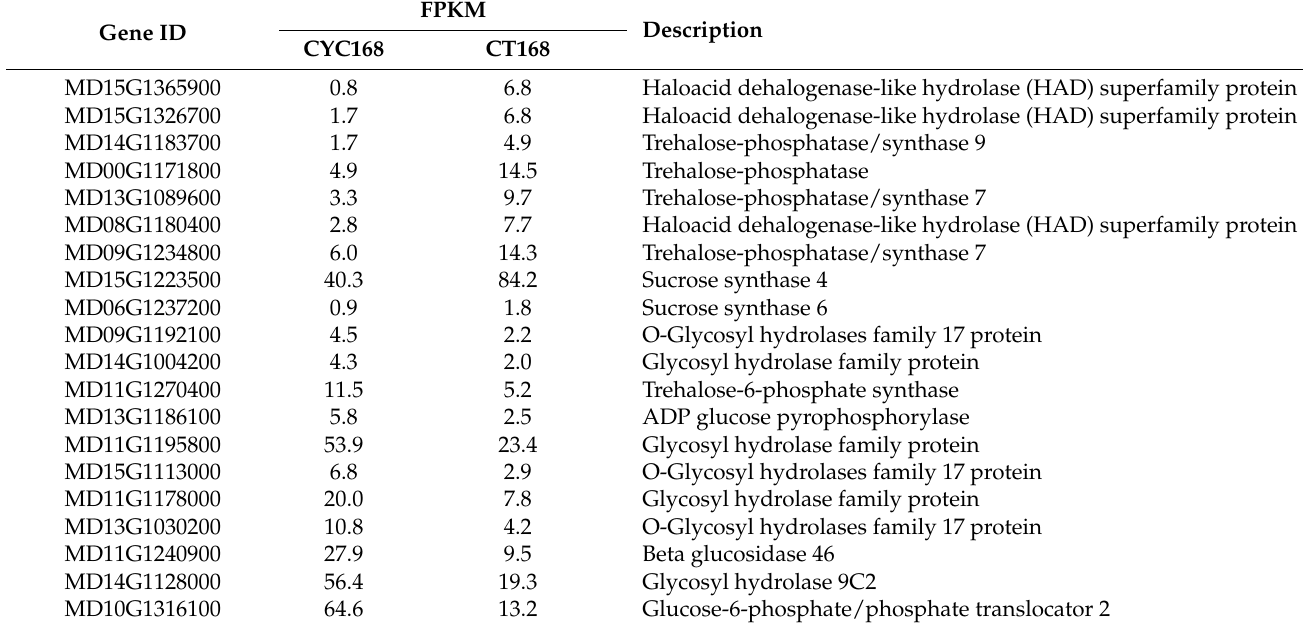
Table 1. The differentially expressed genes in the starch and sucrose metabolism pathways at 168 h after cyclanilide